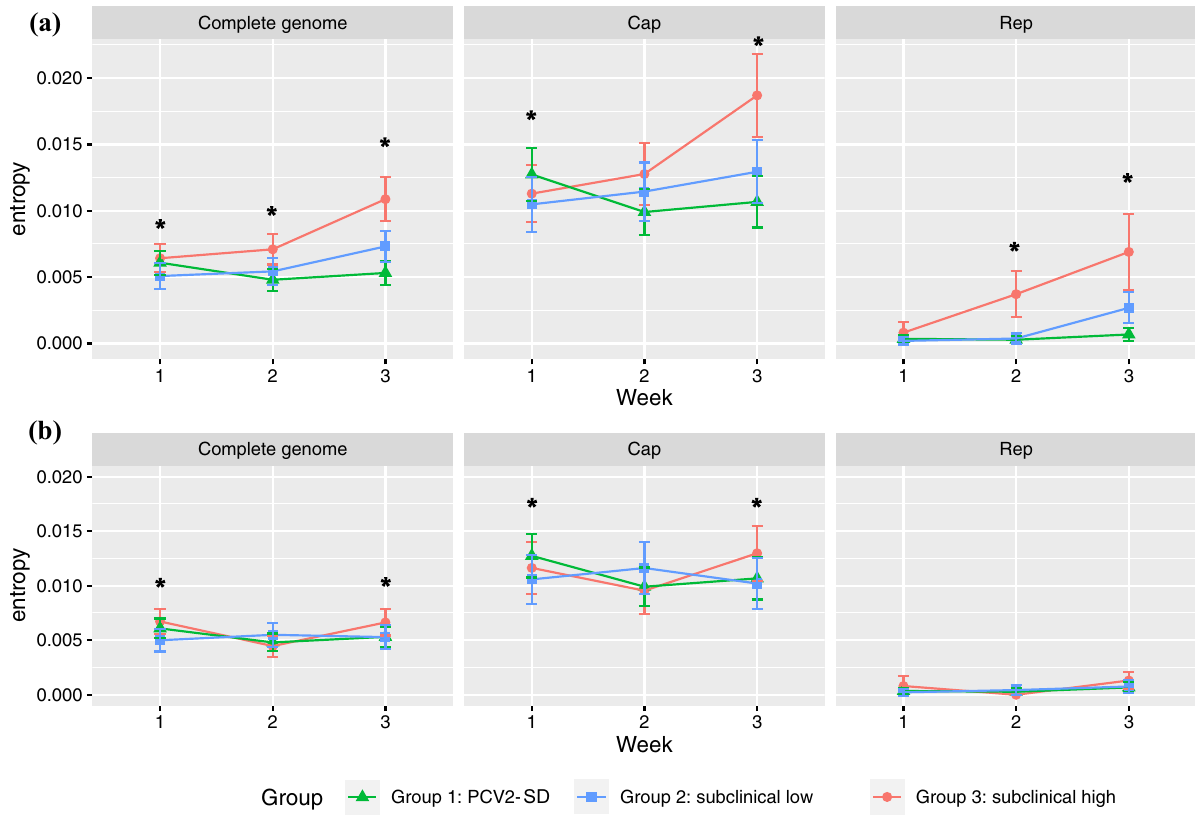
Figure 3. The entropy average and 95% confidence intervals of the complete genome and Cap and Rep coding regions are reported for each wpi. The different groups have been color-coded. The entropy values are reported for the complete dataset (a) and after excluding the ‘hypermutant’ subjects (i.e. 153 and 180) (b) . Asterisks indicate the presence of significant differences among